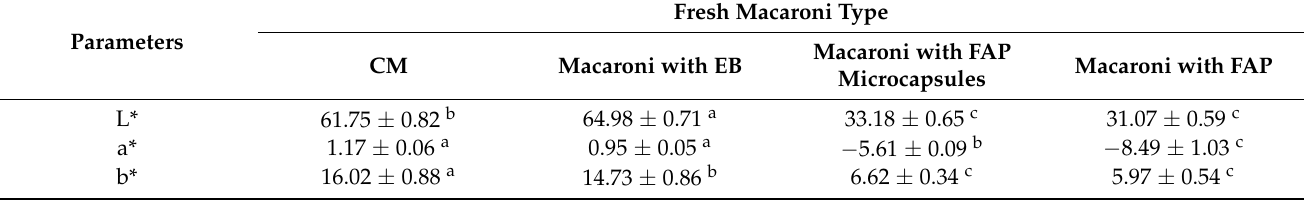
Table 3. Colour parameters of the fresh macaroni formulations enriched with free or microencapsu- lated Azolla fern